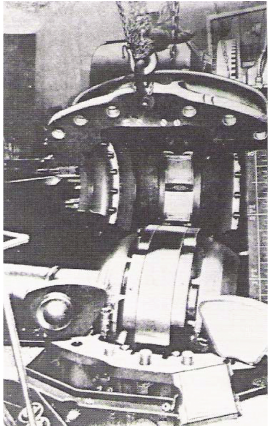
Figure 3: Michell Combined Tilting Pad Journal and Thrust Bearing